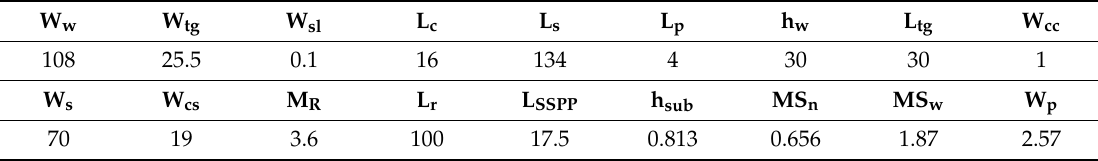
( b ) Figure 9. The fabricated antenna. ( a ) Front view, ( b ) back view. Table 1. Dimensions of the proposed antenna (mm). W w